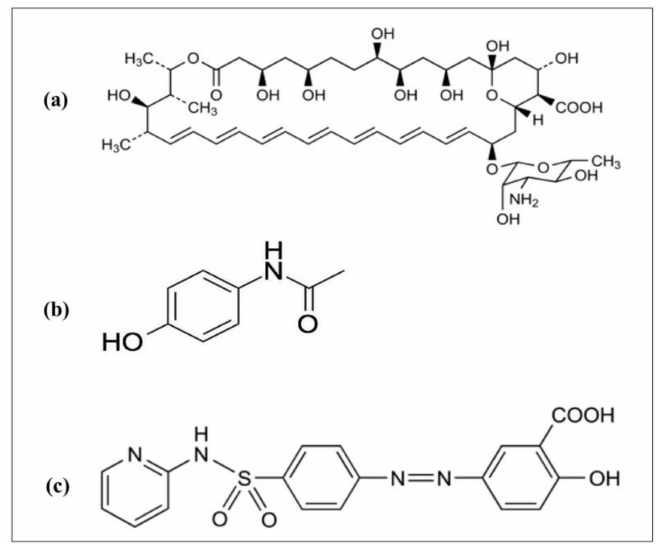
Figure 1. Chemical structures of ( a ) AMB (amphotericin B), ( b ) PAR (paracetamol), and ( c ) SSZ